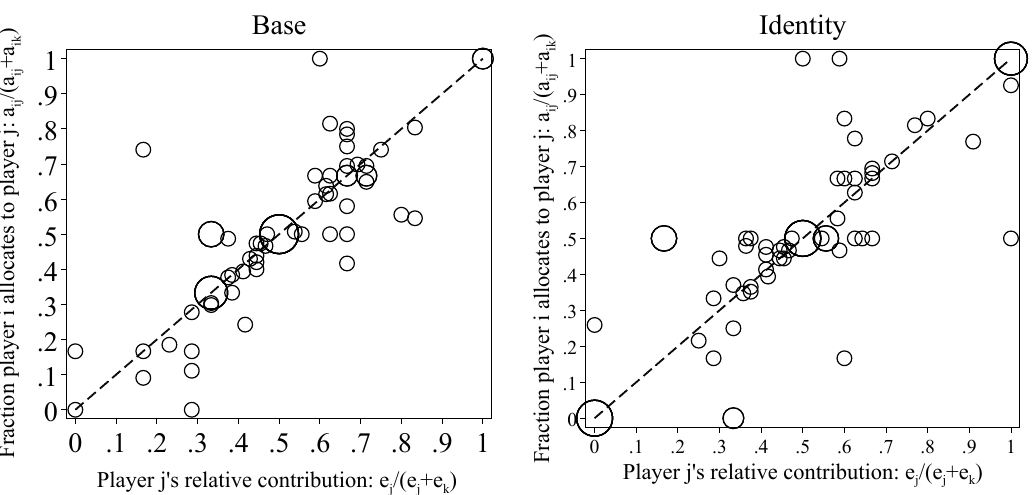
Figure 4. Allocation Decisions in Round 1.